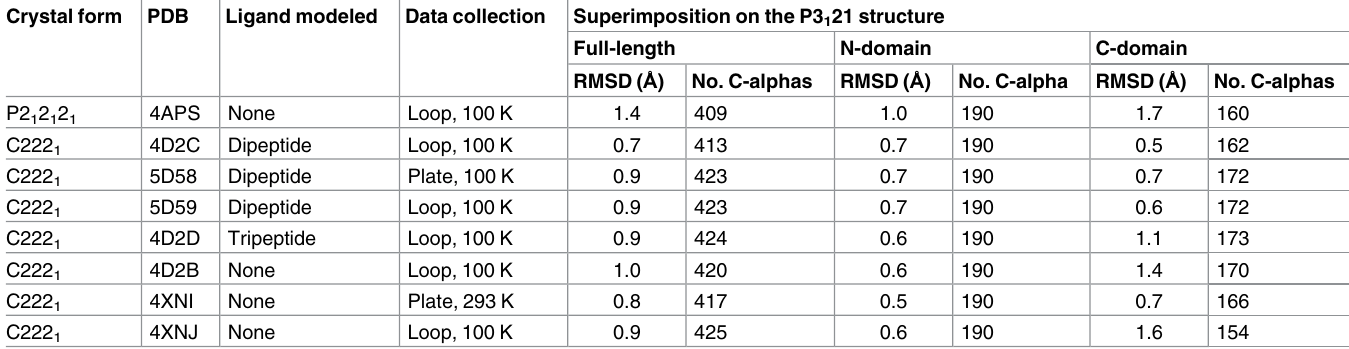
Table 5. Overview of previously determined PepT St structuresand their structural similarity to the P3 1 21 structure reported in this study. Crystal form